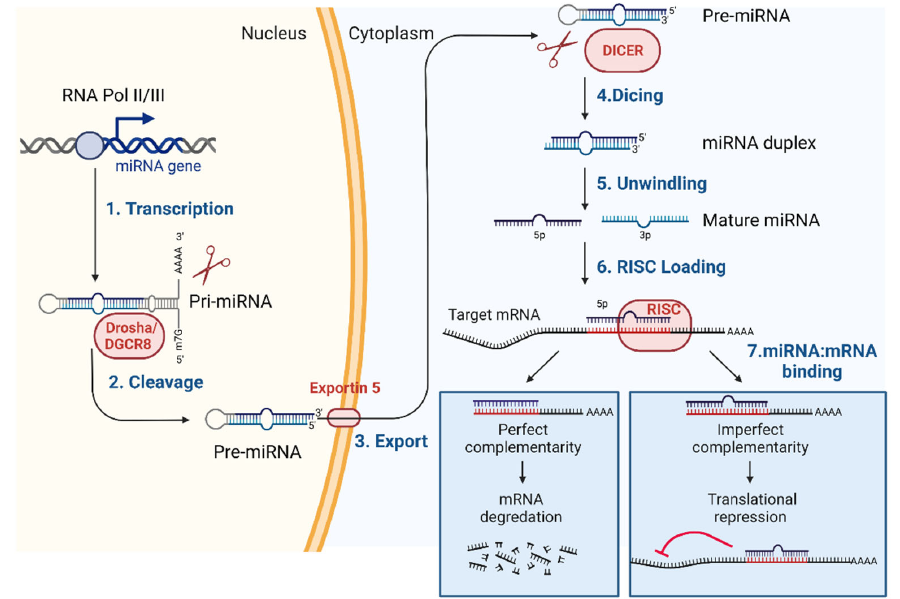
Figure 1. Overview of canonical miRNA biogenesis and function. MiRNA genes are expressed as long transcripts (called pri ‐ miRNAs) that are transcribed by RNA polymerase II or III, and produce a precursor form of miRNA (called pre ‐ miRNA) in the nucleus. The pre ‐ miRNA is then exported to the cytoplasm by exportin 5 and is further processed by the Dicer complex to generate mature miRNA duplexes. Finally, mature miRNA duplexes are separated, and one of the strands is loaded into RISC (RNA silencing complex), which binds to the target mRNA. Mature miRNA regulates the specific gene expression by directly controlling the stability of the mRNA targets or suppressing translation. DGCR8; DiGeorge Syndrome Critical Region 8, m7G; 7 ‐ methylguanosine cap structure. Adapted from “microRNA in cancer” by BioRender.com (accessed on 29 June 2022). Retrieved from https://app.biorender.com/biorender-templates (accessed on 29 June 2022). Agreement number